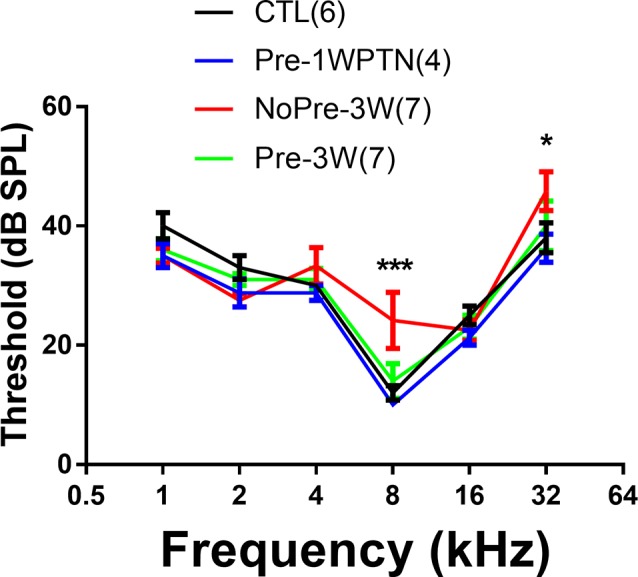
Auditory brainstem response (ABR) threshold audiograms: a comparison across the four subgroups. The sample size of each group is listed in parentheses. The thresholds were significantly higher in the Pre-1WPTN than the control group at 8 and 32 kHz. The number of asterisks indicates the significance level (***p < 0.001, *p < 0.05) of the post hoc pairwise comparison against the control group within each frequency after the two-way ANOVA against the factors of group and frequency.